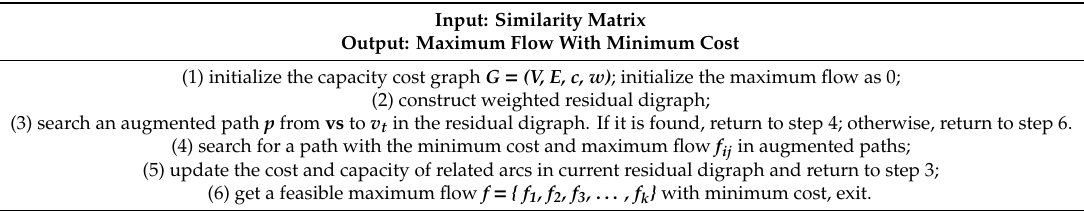
Table A1. Algorithm 1 minimum cost–maximum flow-Based Graph-Matching.